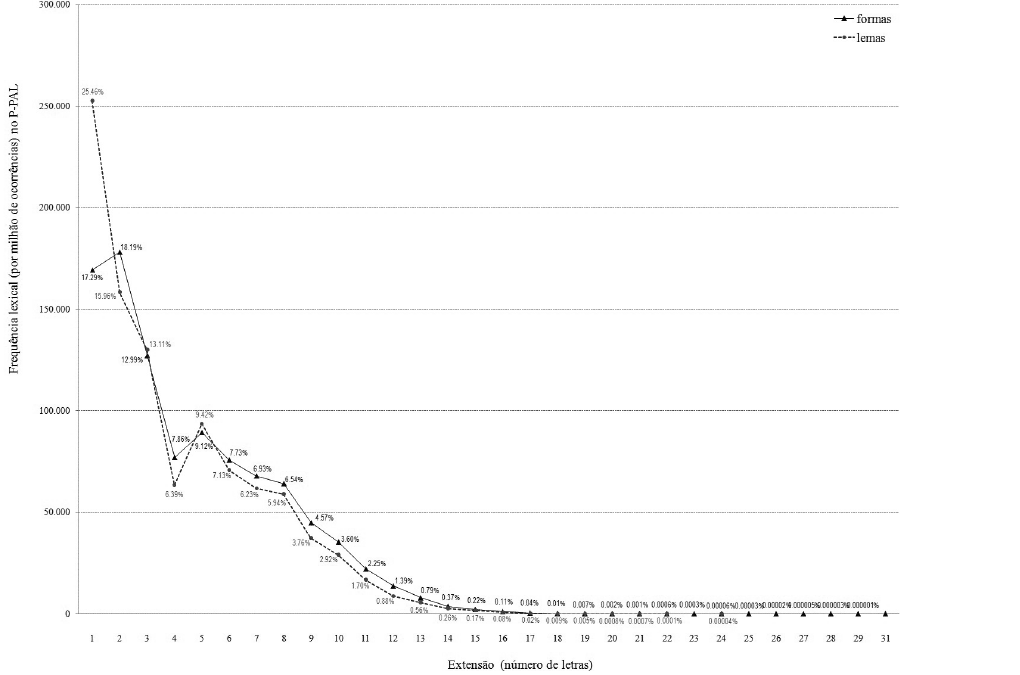
Figura 3 . Distribuição das frequências acumuladas (por milhão de ocorrências) das 208.642 formas e 52.404 lemas do P-PAL por extensão de palavra (número de